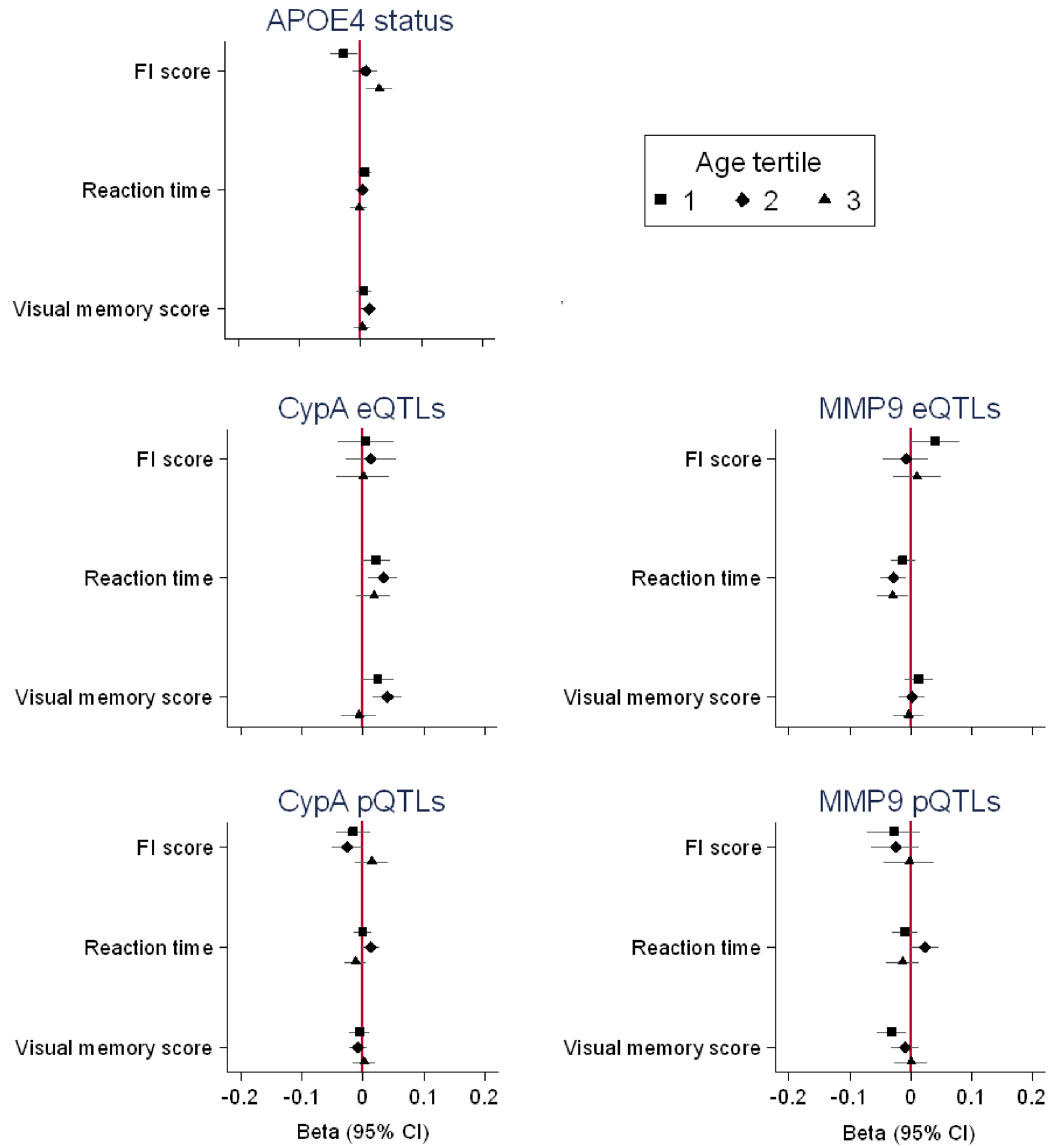
Figure 1. Causal effects of APOE4 carrier status (carrier vs non-carrier) and CypA and MMP9 eQTL and pQTL PRSs on the continuous cognitive function outcomes in the UK Biobank, by age tertiles. All outcomes are in standard deviation units and higher values represent poorer